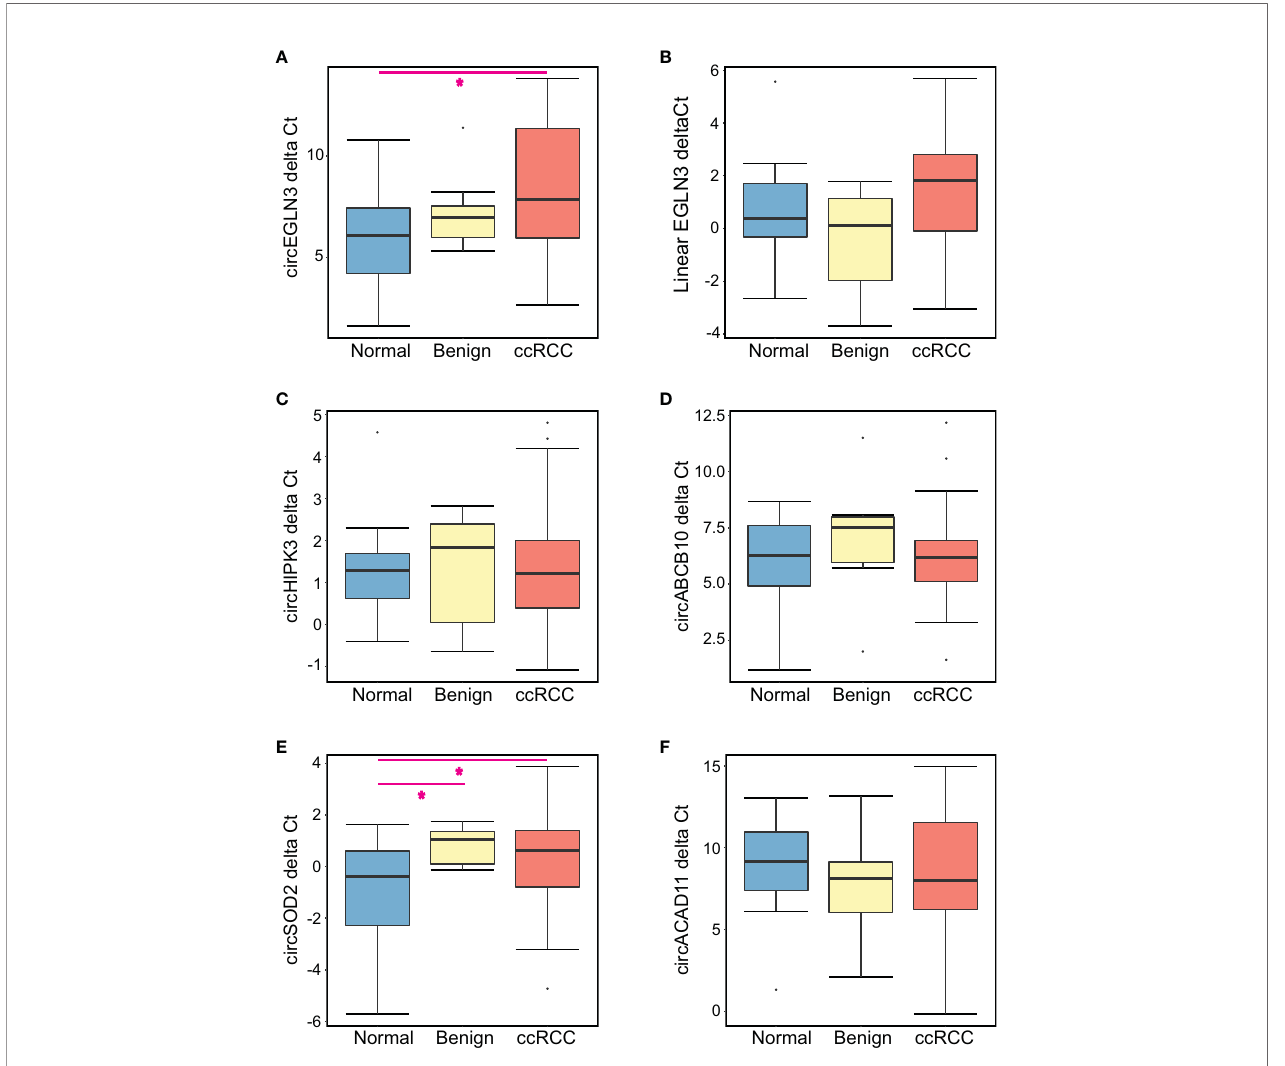
FIGURE 1 | Summary of expression levels of all candidate markers for each patient group. The delta Ct for each candidate RNA marker was calculated using GAPDH Ct values for all urine samples analyzed. Boxplots show the median delta Cts as well as the fi rst and third quartile for (A) circEGLN3, (B) linear EGLN3, (C) circHIPK3, (D) circABCB10, (E) circSOD2, and (F) circACAD11. Kruskal-Wallis analysis was performed to compare all patient groups, with pairwise comparisons for signi fi cantly altered RNA markers (*p <